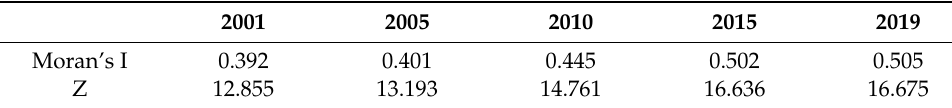
Table 4. Statistical table of global Moran’s I from 2001 to